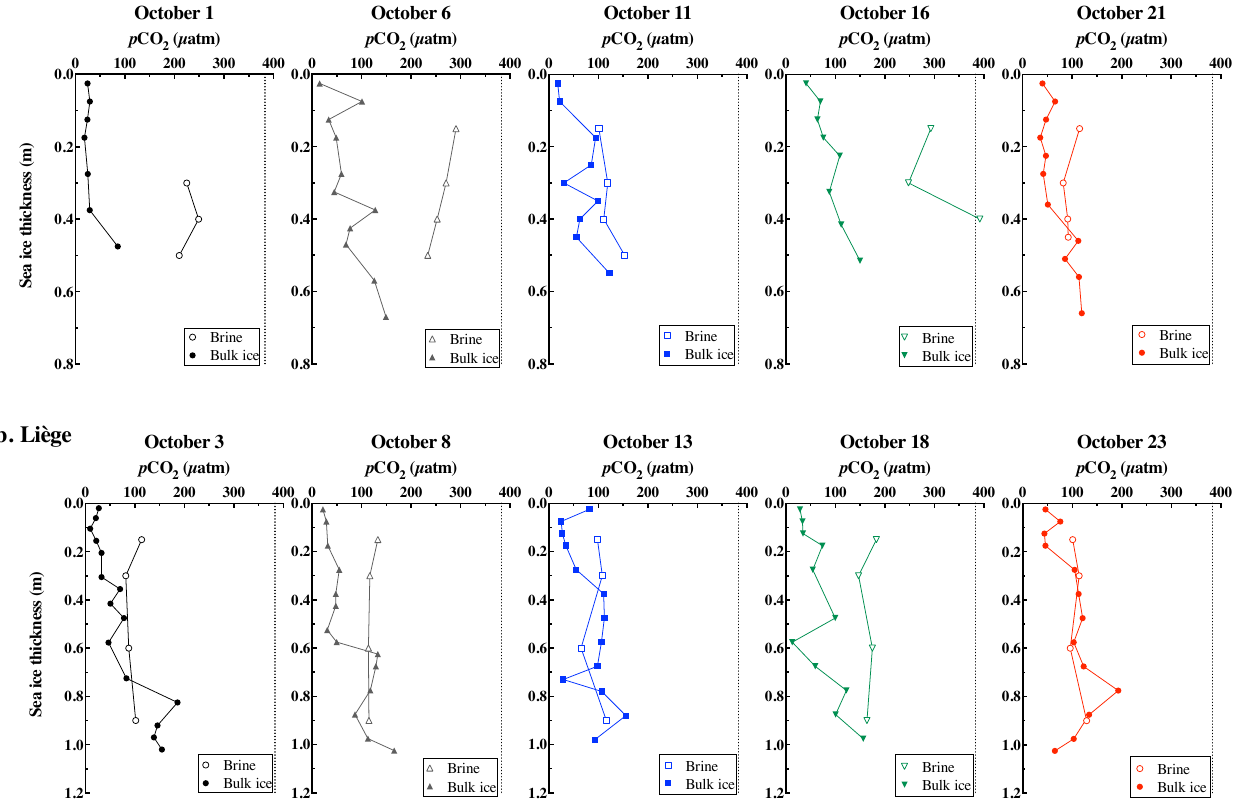
Figure 6. Vertical profiles of the in situ brine p CO 2 (in µatm) and bulk ice p CO 2 (in µatm) from the Brussels (top panels) and Liège (bottom panels) sites. Data at 0.075–0.125 and 0.175m depth of the station on 16 October were measured while the brine volume was 4.1–4.4 and 4.6%,